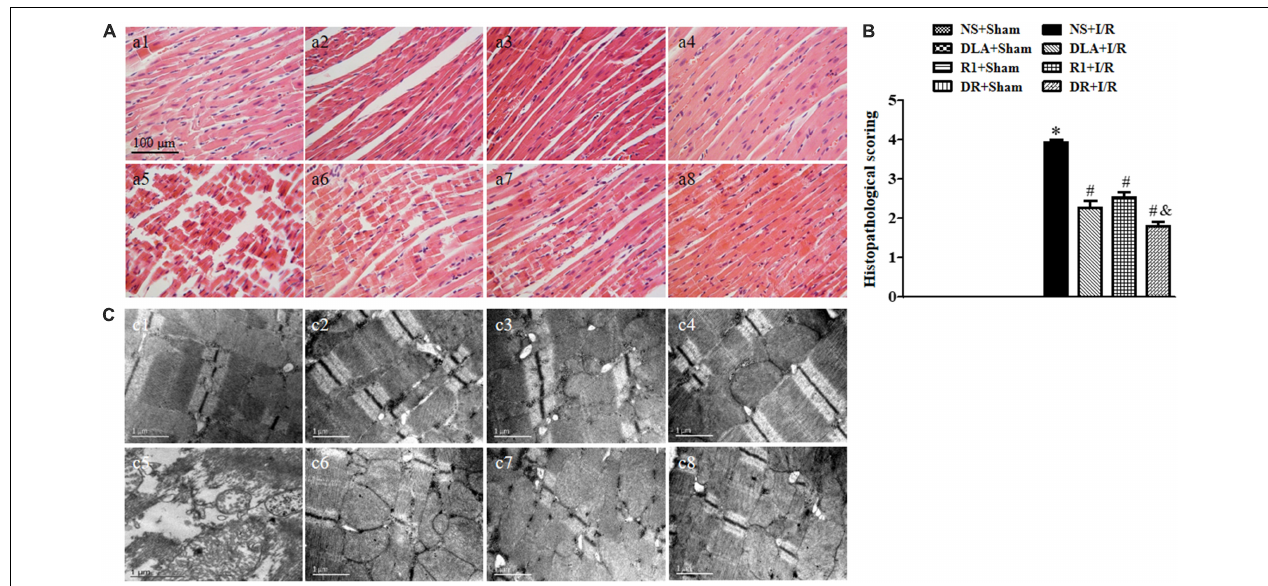
FIGURE 5 | The effect of DLA, R1, and DR pretreatment on myocardial histology and ultrastructure in rats exposed to I/R for 90 min. (A) Examples of HE-stained histological photographs of myocardium in the NS + Sham group (a1) , the DLA + Sham group (a2) , the R1 + Sham group (a3) , the DR + Sham group (a4) , the NS + I/R group (a5) , the DLA + I/R group (a6) , the R1 + I/R group (a7), and the DR + I/R group (a8) . Bar = 100 µ m. (B) Histological analysis of hematoxylin-eosin (HE) staining. Data are mean ± SEM (n = 3). * p < 0.05 vs. NS + Sham group; # p < 0.05 vs. NS + I/R group; & p < 0.05 vs. DLA + I/R group and R1 + I/R group. (C) Examples of electron micrographs from the NS + Sham group (c1) , the DLA + Sham group (c2) , the R1 + Sham group (c3) , the DR + Sham group (c4) , the NS + I/R group (c5) , the DLA + I/R group (c6) , the R1 + I/R group (c7), and the DR + I/R group (c8) .